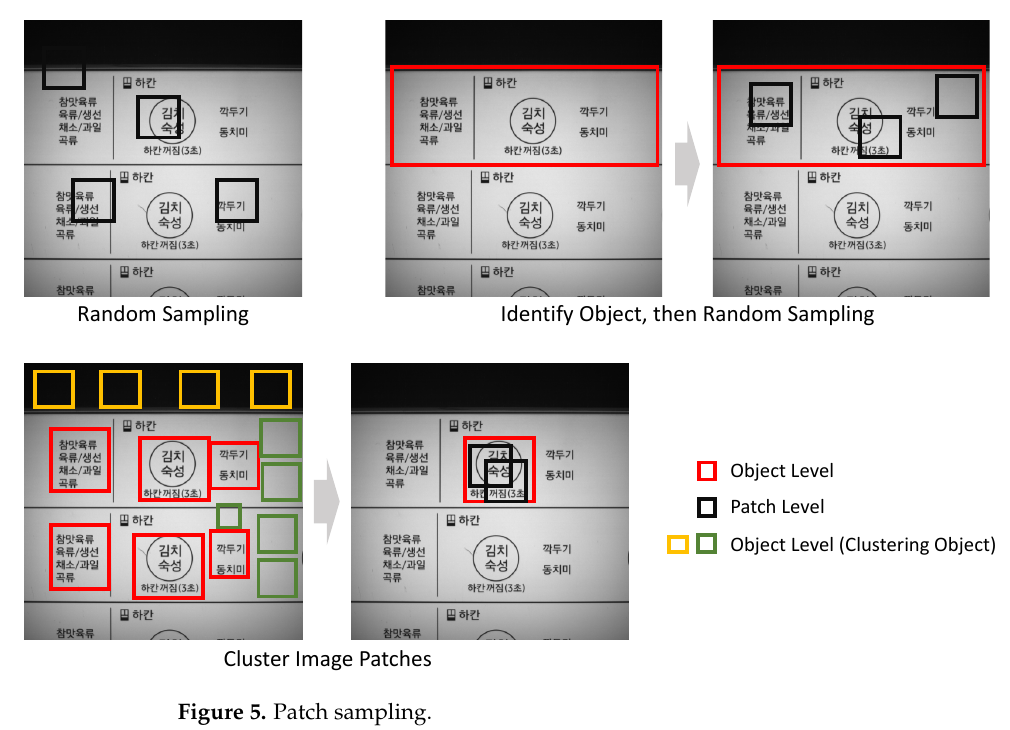
Figure 5. Patch sampling.